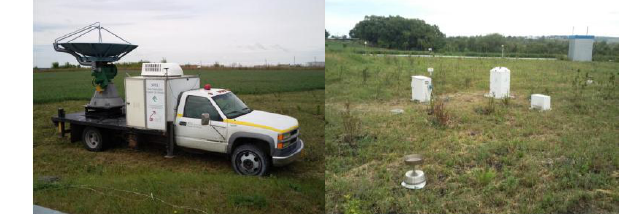
Figure 2. Pictures of deployed instruments during the Moldova field experiment: XPol radar Fig. 2. Pictures of deployed instruments during the Moldova field (left panel) disdrometer and rainguages (right panel) located at Chisinau site. experiment: XPol radar (left panel) disdrometer and raingauges